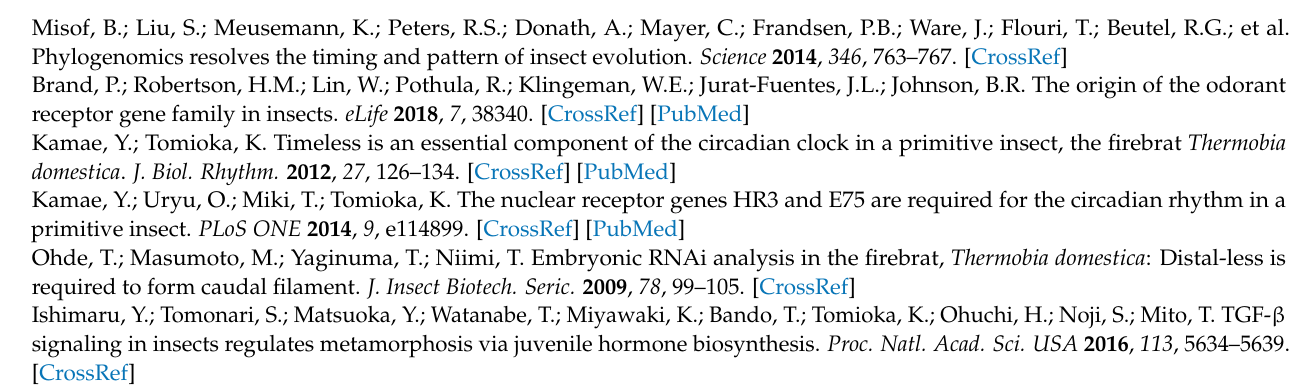
Table S2: Primers used for qRT-PCR analysis of Myo gene expression and dsRNA